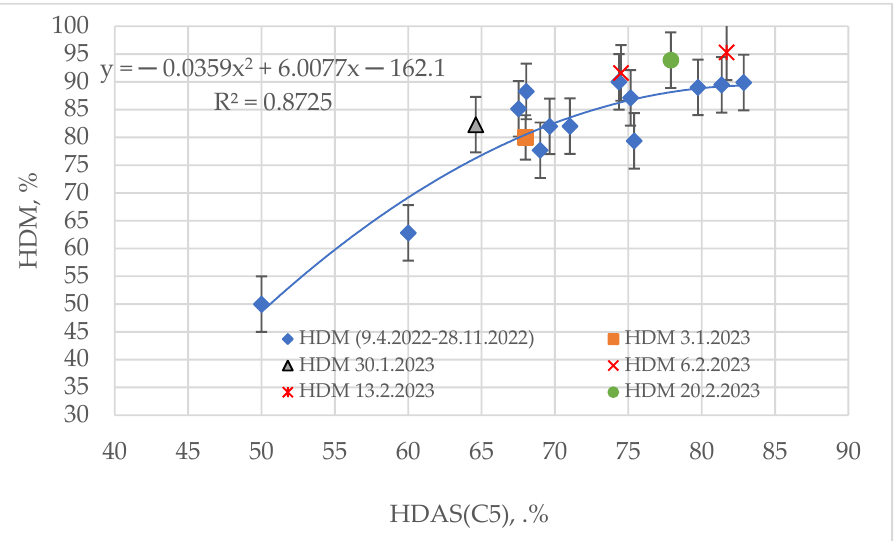
Figure 14. Relation between HDM, and HDAs (C 5 ) for the commercial ebullated bed vacuum residue hydrocracking.